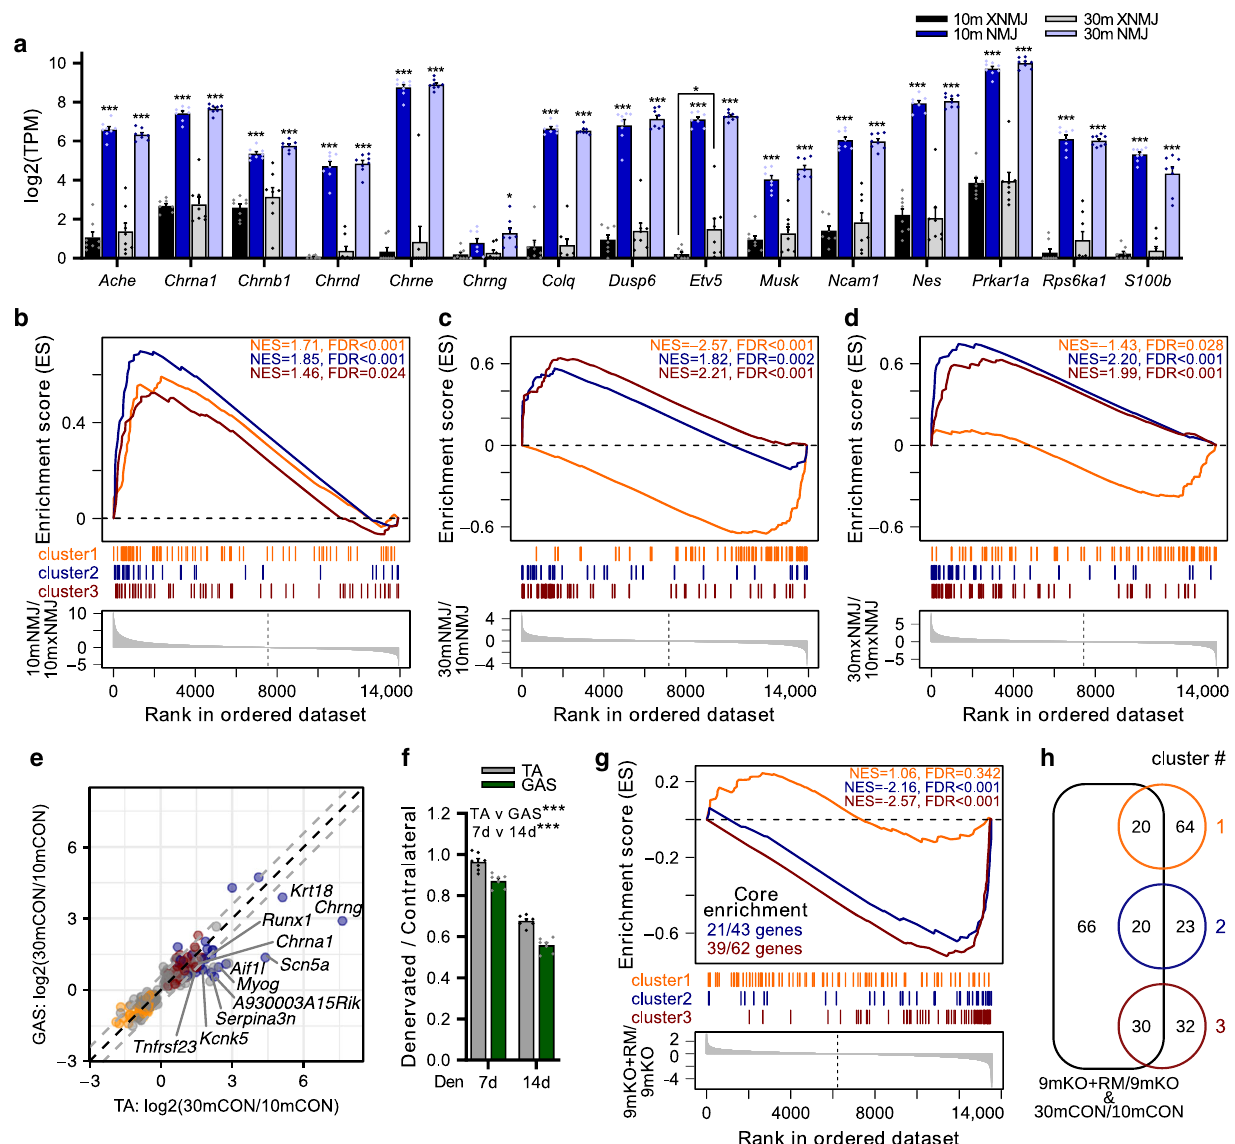
Fig. 7 The neuromuscular junction (NMJ) is a focal point of mTORC1-driven sarcopenic signaling. a The expression of genes known to be enriched at the NMJ based on mRNA-seq data generated from synaptic (NMJ) and extra-synaptic (xNMJ) regions of TA muscle from 10-month-old (10m) and 30-month-old (30m) mice. NMJ and xNMJ samples were collected using laser-capture microdissection on α -bungarotoxin- stained cross sections. Gene set enrichment analysis (GSEA) comparing the expression of genes in ( b ) NMJ versus xNMJ regions of 10m mice. c NMJ regions of 30m versus 10m groups and d xNMJ regions of 30m versus 10m groups. The distribution of genes from clusters 1, 2, and 3 was examined in lists of genes ranked by the magnitude of changes between conditions. Signi fi cance was set at the false discovery rate (FDR)<0.01. e Scatterplot of fold-change expression of genes aligned with the aging PC3 from Fig. 6a between 30m and 10m for gastrocnemius (GAS) and tibialis anterior (TA). Labeled genes show a>log 2 (1.5)-fold change between TA and all three other muscles. Genes from clusters 1, 2, and 3 are colored orange, red, and blue, respectively, while gray dots are genes aligned with aging PC3, but not belonging to clusters 1 – 3. f Muscle mass of TA and GAS muscles denervated for 7 or 14 days relative to the contralateral control leg. g GSEA comparing the distribution of genes from clusters 1 – 3 in the ranked list of gene expression changes between 9-month-old TSCmKO mice (9mKO) and 9-month-old TSCmKO mice subjected to 3 days of rapamycin (8mgkg − 1 day − 1 ) treatment (9mKO + RM). For clusters signi fi cantly enriched, the number of genes reaching the “ leading edge ” threshold are indicated. h Venn diagram of genes differentially expressed between 9mKO + RM and 9mKO, and aligned with the aging PC3, and their overlap with genes in clusters 1 – 3. Group numbers are ( a – d ) 8, ( e ) 6, ( f ) 7, and ( g ) 5. For ( e ), each dot represents the log-fold change between means of mice in each group. Data are means±SEM. Two-way ANOVAs ( a , f ) with Tukey ’ s post hoc test ( a ) were used to compare between data. *, **, and *** denote a signi fi cant difference between groups of P <0.05, P <0.01, and P <0.001, including improved muscle function and a 20% increase in life- span, the mTOR Δ / Δ mouse exhibits an exacerbated age-related